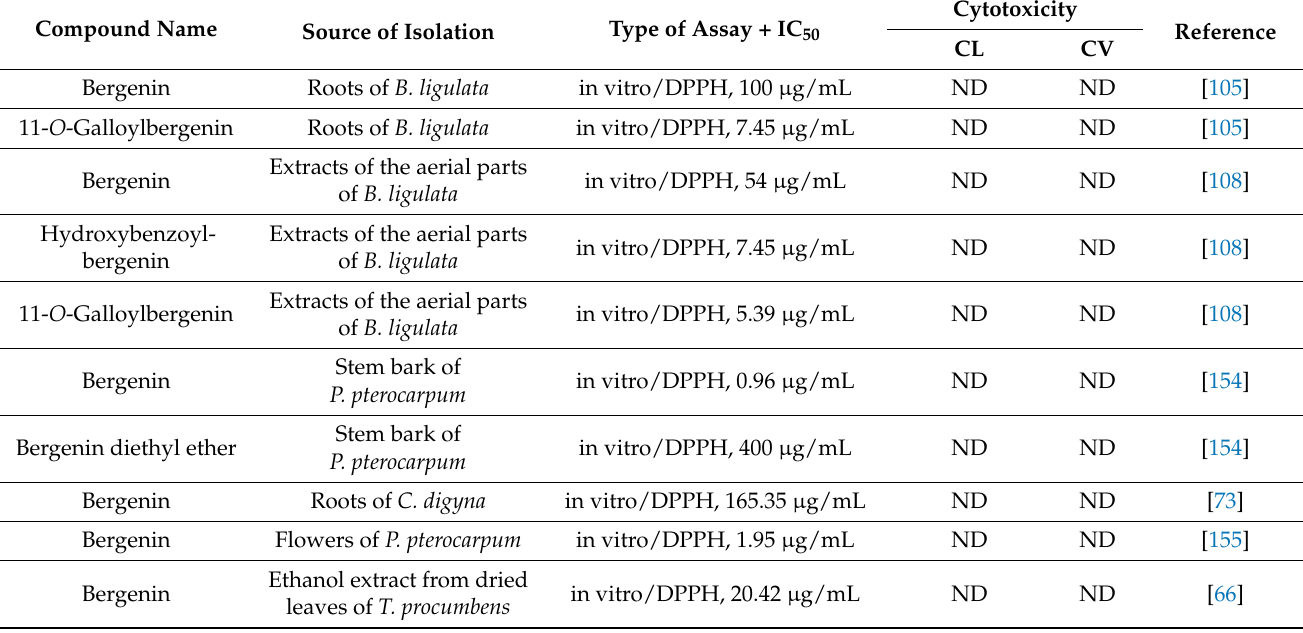
Table 4. Studies relating to the antioxidant activity of bergenin and its